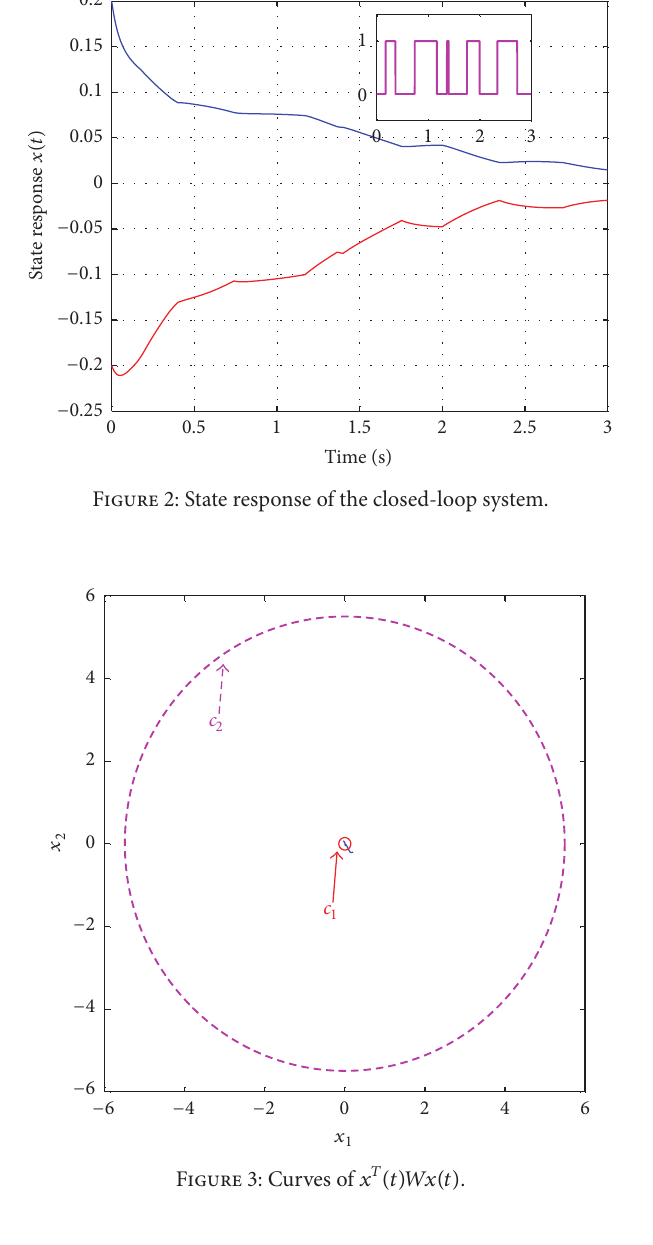
Figure 3: Curves of 𝑥 𝑇 (𝑡)𝑊𝑥(𝑡) .